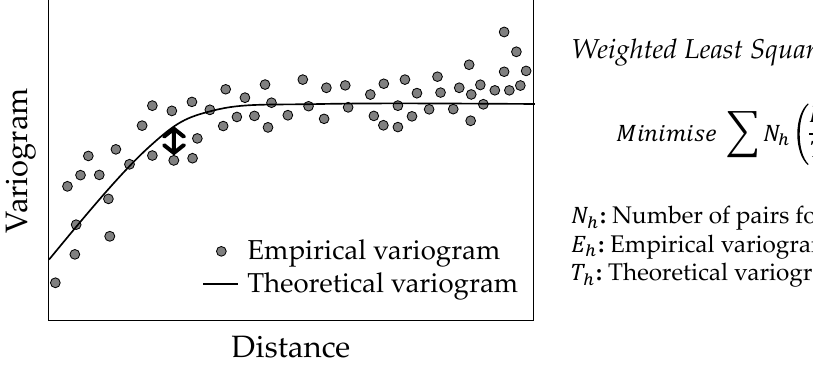
Figure 8. Variogram optimization using the weighted least squares (WLS) of the dissimilarity of the empirical and theoretical